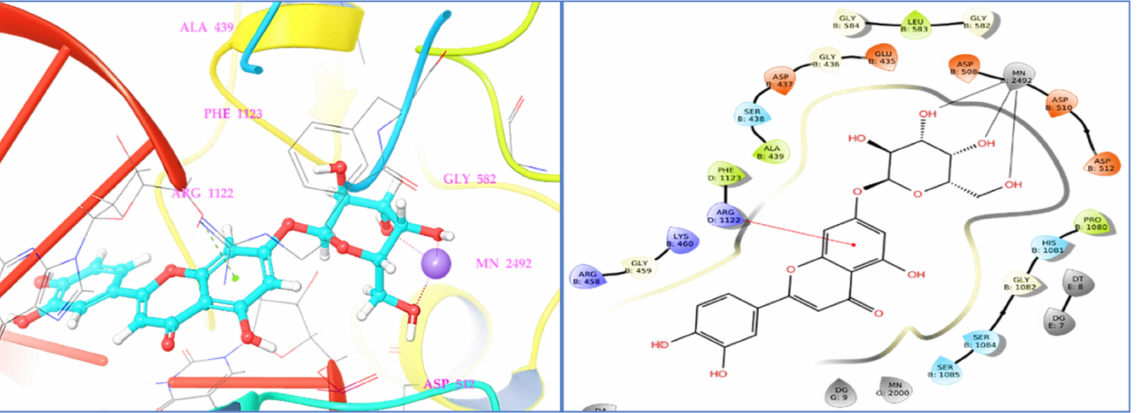
Figure 4. Two- and three-dimensional residual interactions network of luteolin 7-glucoside against the active site of S. aureus IIA topoisomerase (PDB ID: 2XCT).